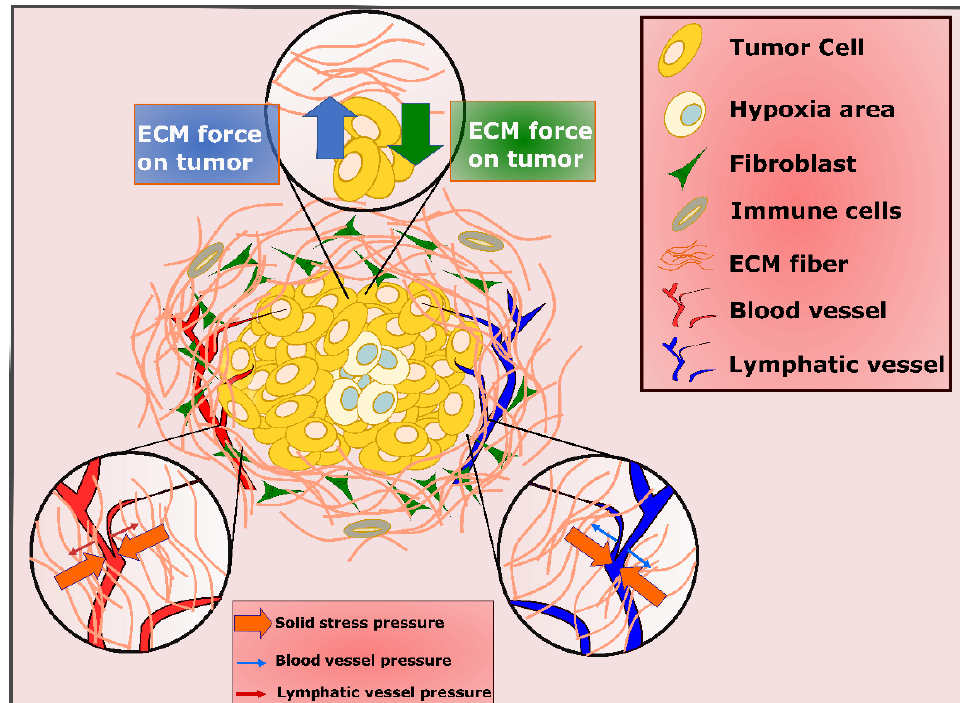
Figure 4. The biophysical tumor microenvironment.